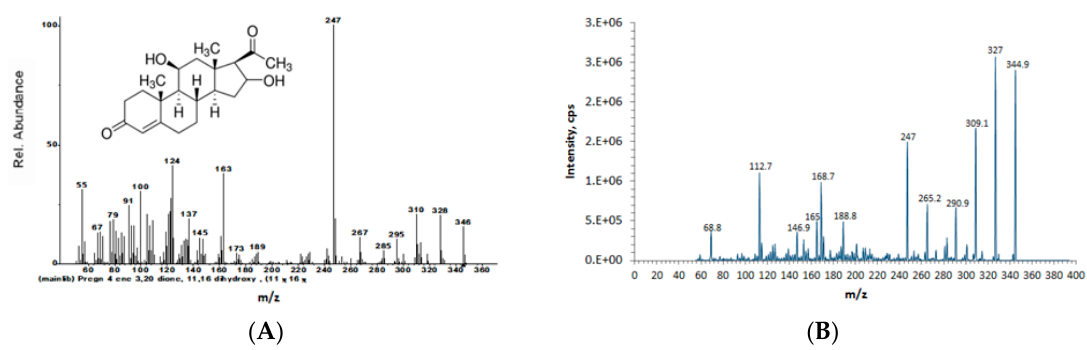
Figure 5. Relevant tandem mass (MS/MS) spectra. ( A ) 11, 16-Dihydroxypregn-4-ene-3, 20-dione (from NIST 14 mass spectral library); ( B ) isolated and purified compound ( 3 ).